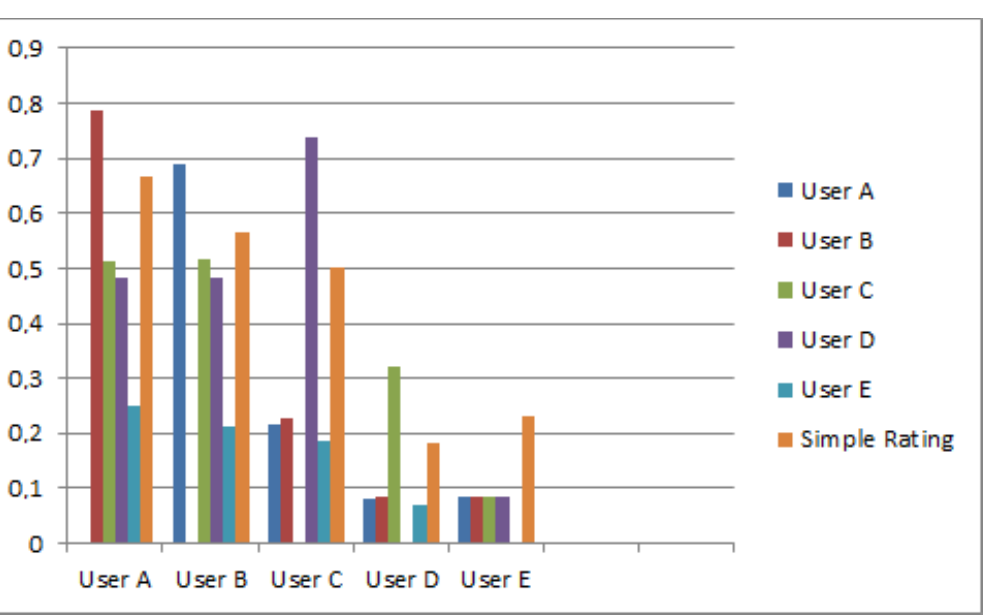
Figure 3. Comparison with Simple Rating-Based